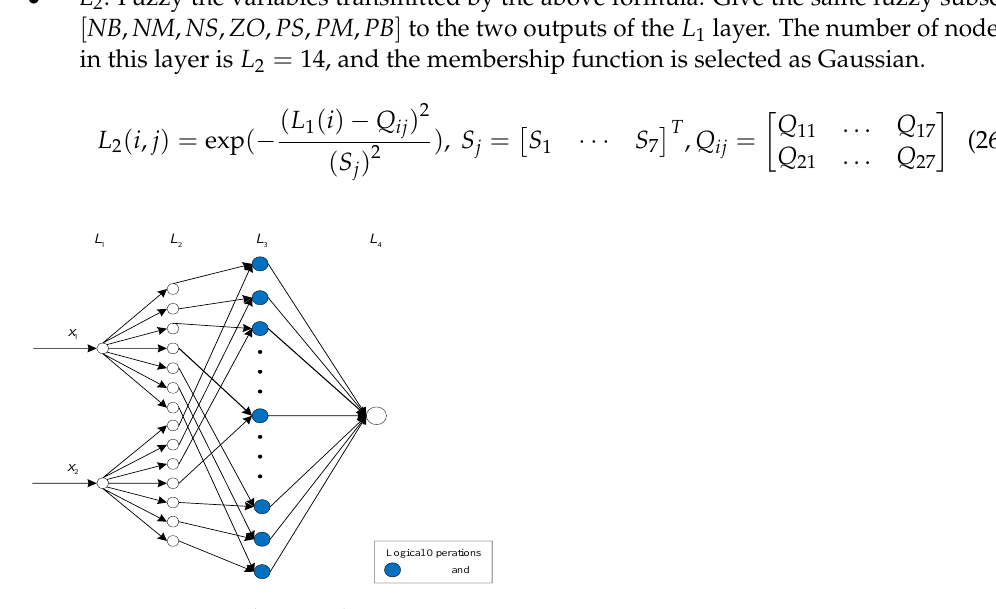
Figure 3. Fuzzy Neural Network Structure.